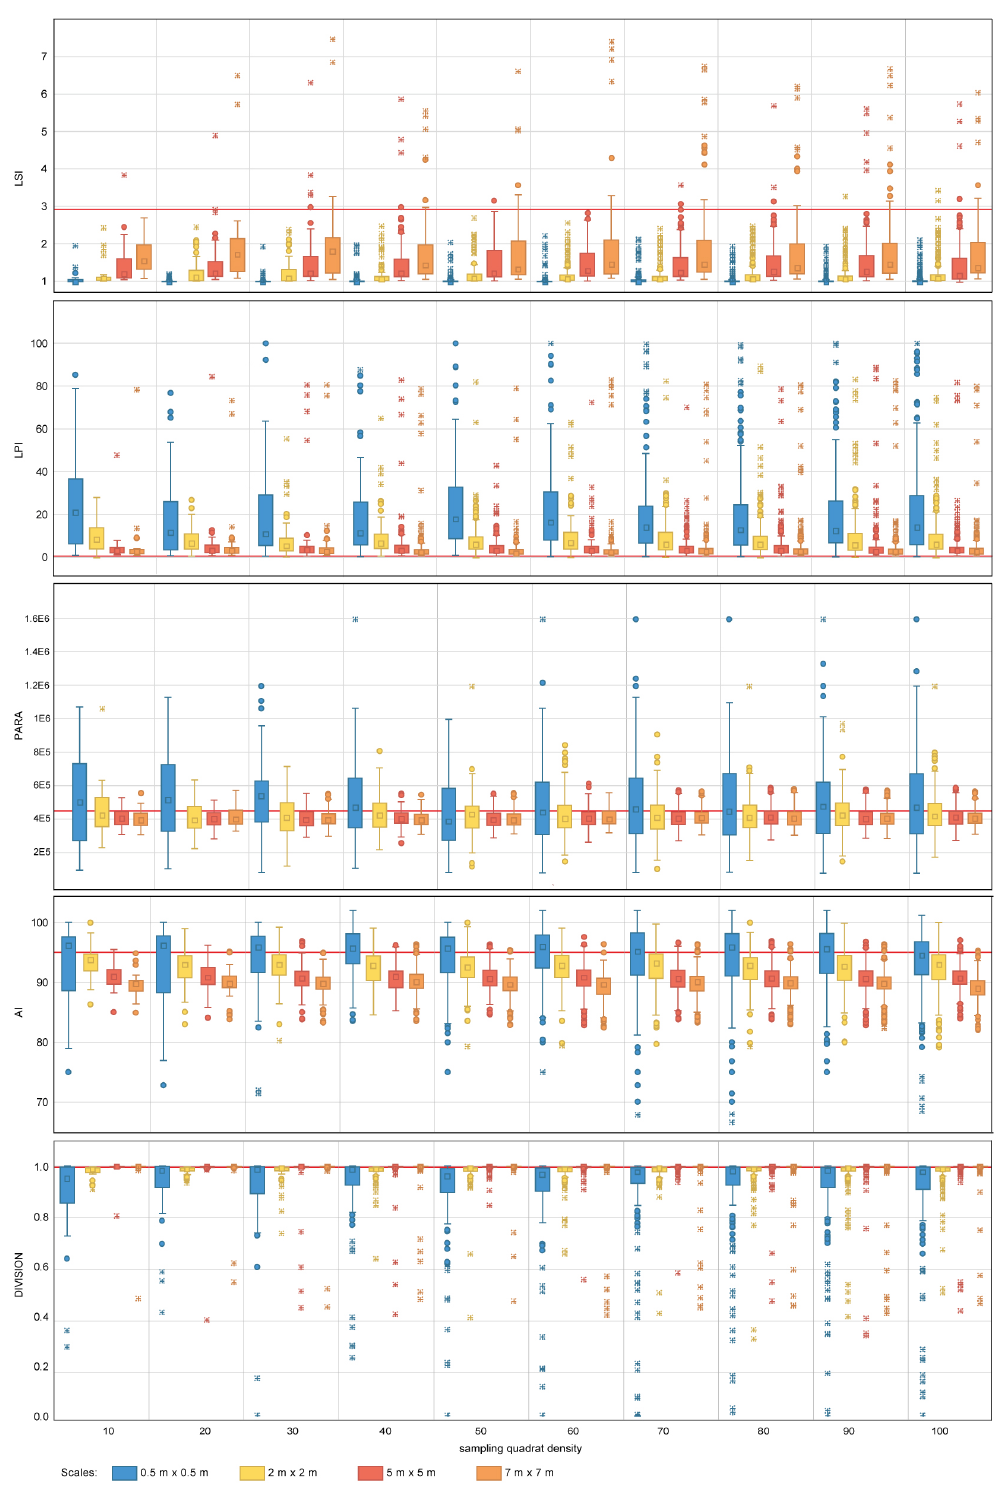
Figure 7. Area-density-edge, shape, contagion and interspersion metric values obtained for the random sampling strategy for the range of scales and quadrat densities considered. The red horizontal line indicates the metric value obtained on the total area mapped. LSI, LPI, PARA, AI and DIVISION stand for Landscape Shape Index, Largest Patch Index, Perimeter Area Ration Mean, Aggregation Index and Division Index, respectively. The boxplots show the first, second (median), third and fourth quartiles. Circles and crosses indicate outliers and extreme values,